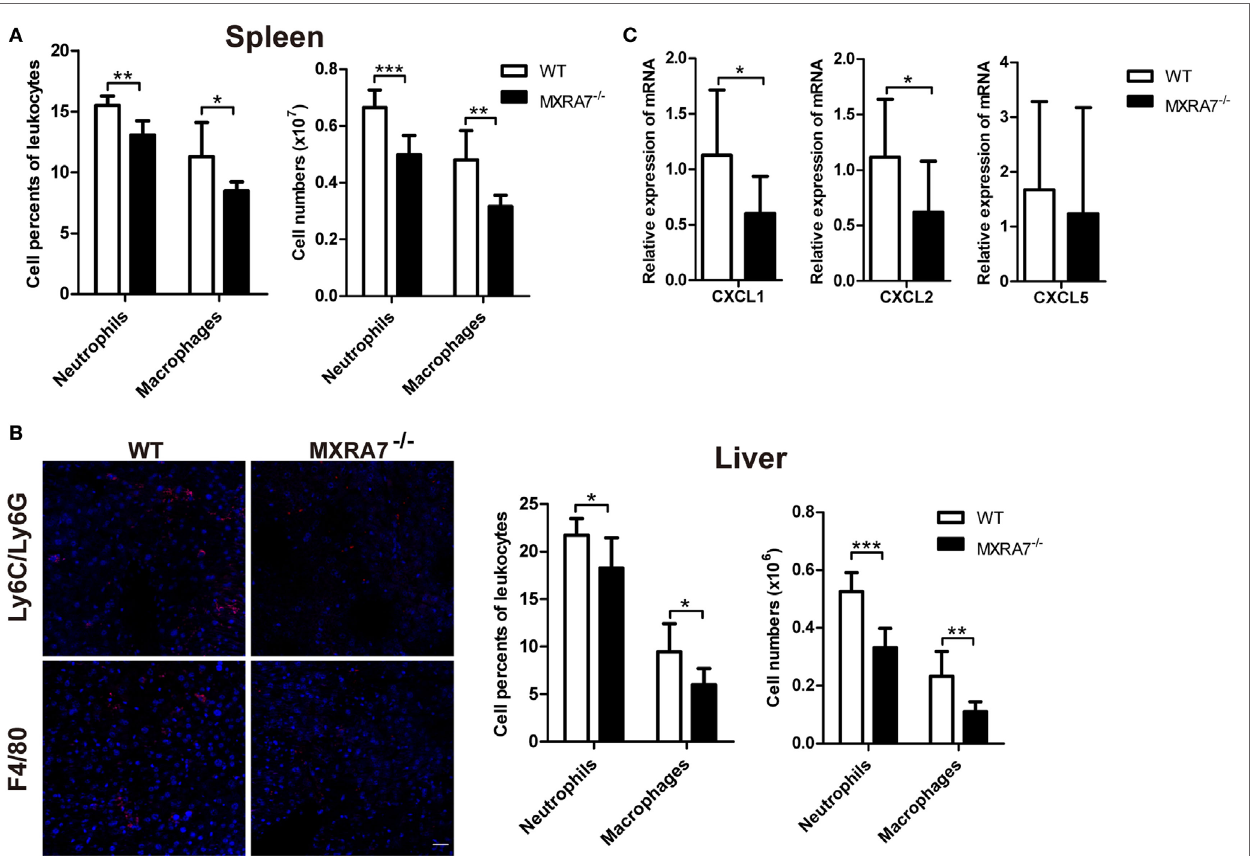
FigUre 2 | Matrix remodeling associated 7 (MXRA7) deficiency decreases neutrophils and macrophages infiltration in liver. (a,B) Splenocytes and intrahepatic leukocytes were isolated from 1 ml/kg CCl 4 -challenged wild-type (WT) and MXRA7 − / − mice ( n = 7 each group) 24 h after CCl 4 injection and used for FACS analysis. (B) Immunofluorescence staining of Ly6C/Ly6G (in red) and F4/80 (in red) in liver sections from CCl 4 -treated WT and MXRA7 − / − mice. Scale bar = 25 µm. Ly6C/ Ly6G + neutrophils and F4/80 + macrophages in spleen (a) and in liver (B) were measured. Data shown are the representative of three independent experiments. (c) Livers were harvested from mice which were sacrificed 24 h after 1 ml/kg CCl 4 injection. Expression of CXCL1, CXCL2, and CXCL5 mRNAs in livers was detected by reverse transcription-quantitative real-time PCR. The data shown are the summary of three experiments. * p < 0.05, ** p <